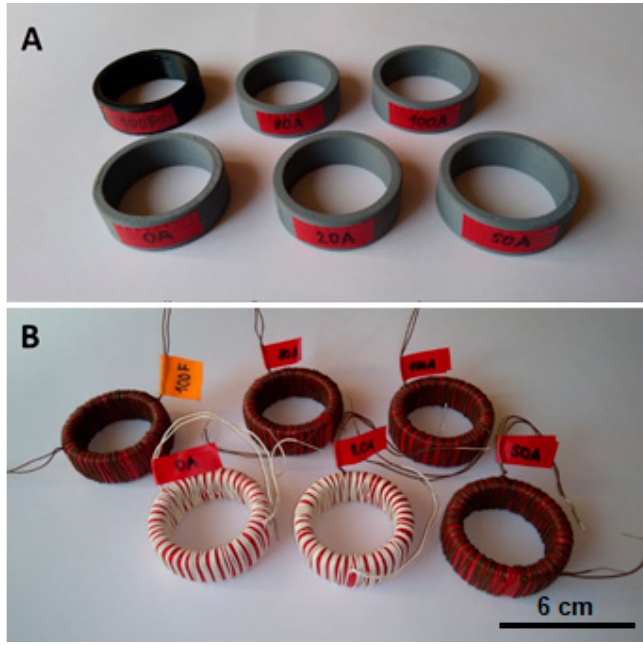
Figure 2. Photographic images of the testing samples for the magnetic properties measurement, ( A )—Samples after 3D printing, ( B )—Samples with winding